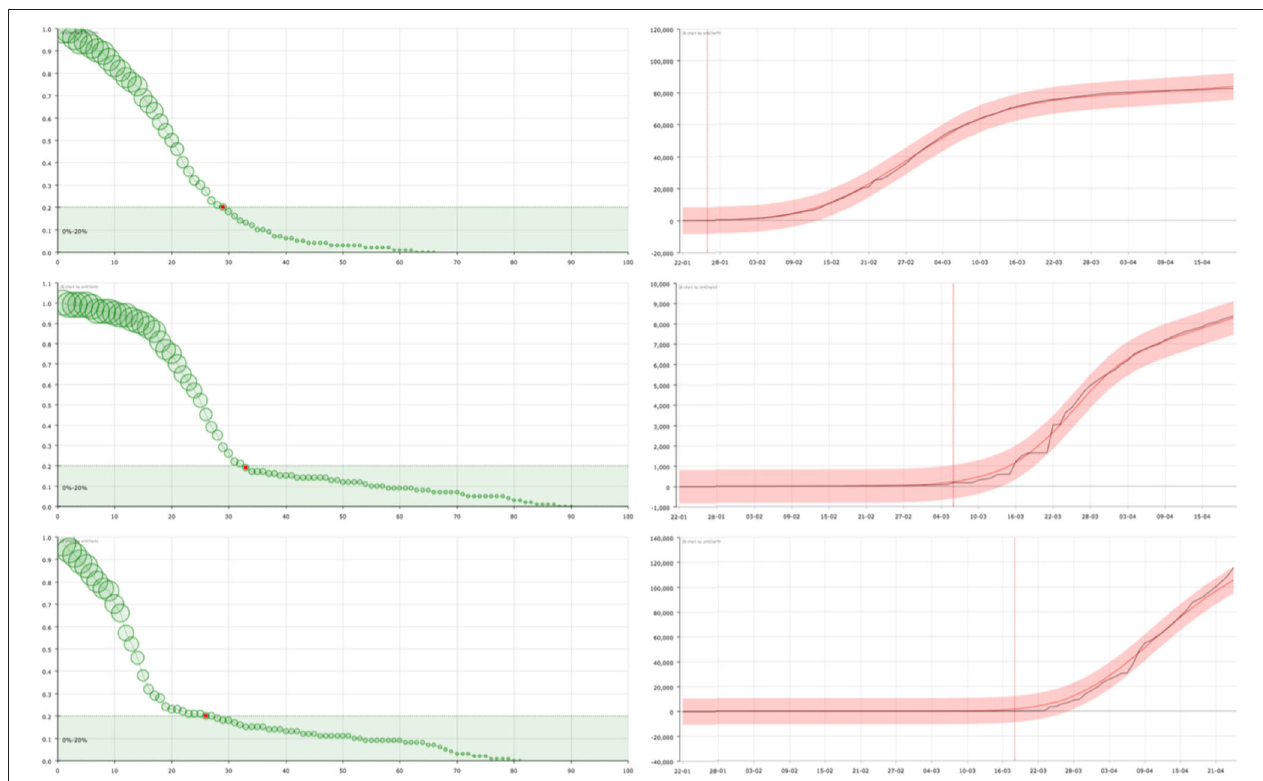
FIGURE 3 | On the right, curve fitting of the sum of the accumulated number of recovered and dead people in China (top) , South Korea (center) , and Germany X ). The x-axis represent the date and the y-axis represents the number of cases. Vertical (bottom) : black line is the real value ( X ) and red line is the approximation ( b line signs the 100 cases. On the left, the corresponding survival curve of the virus S . The red point signs the number of days after which a standard individual has a probability of staying in the group of infected people smaller than 0.2. This value has been arbitrarily set as an aid to the visualization of the decreasing of the curve. The size of the balls is proportional to their value at the point.